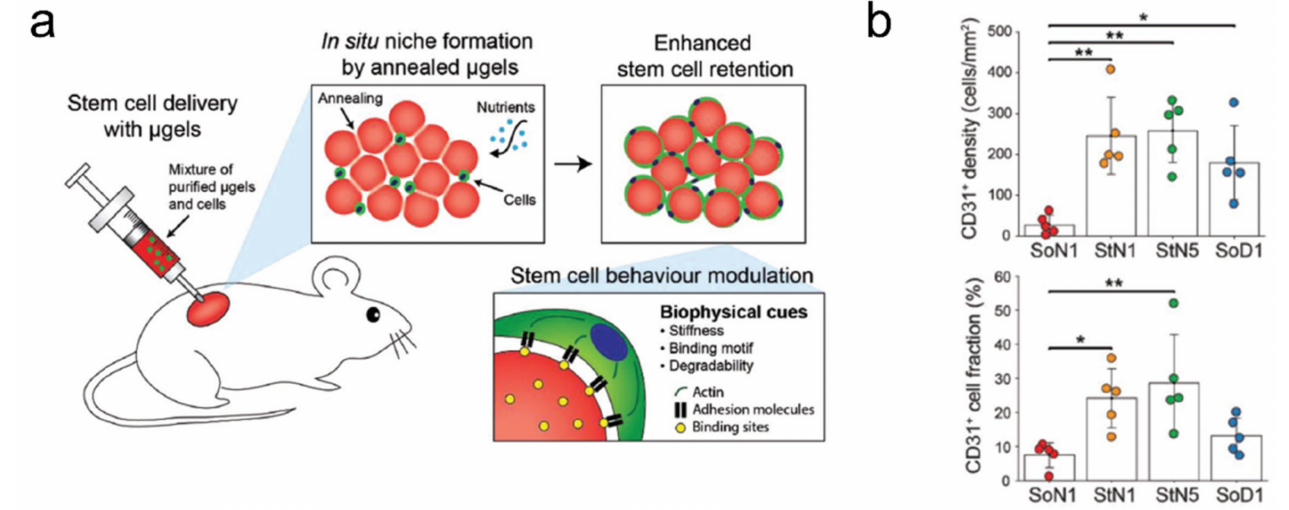
Figure 6. In vivo delivery of microporous annealed particles (MAPs) for wound healing. ( a ) Schematic of subcutaneous injection of MAP for effective vascular regeneration. ( b ) Results of injecting MAPs with four distinctive compositions (SoN1, StN1, StN5, and SoD1), leading to vascular endothelial cell (CD31+) regrowth in injection site; adapted with permission from [71]. Copyright 2019